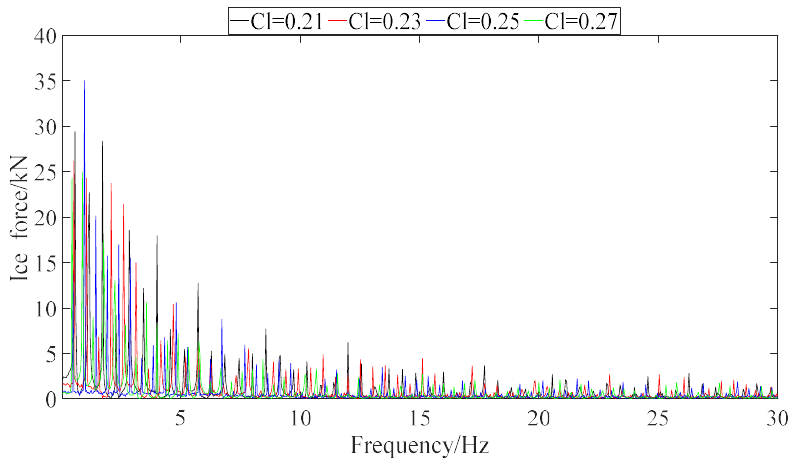
Figure 11. Frequency domain curves with different length coefficients ( C l ).